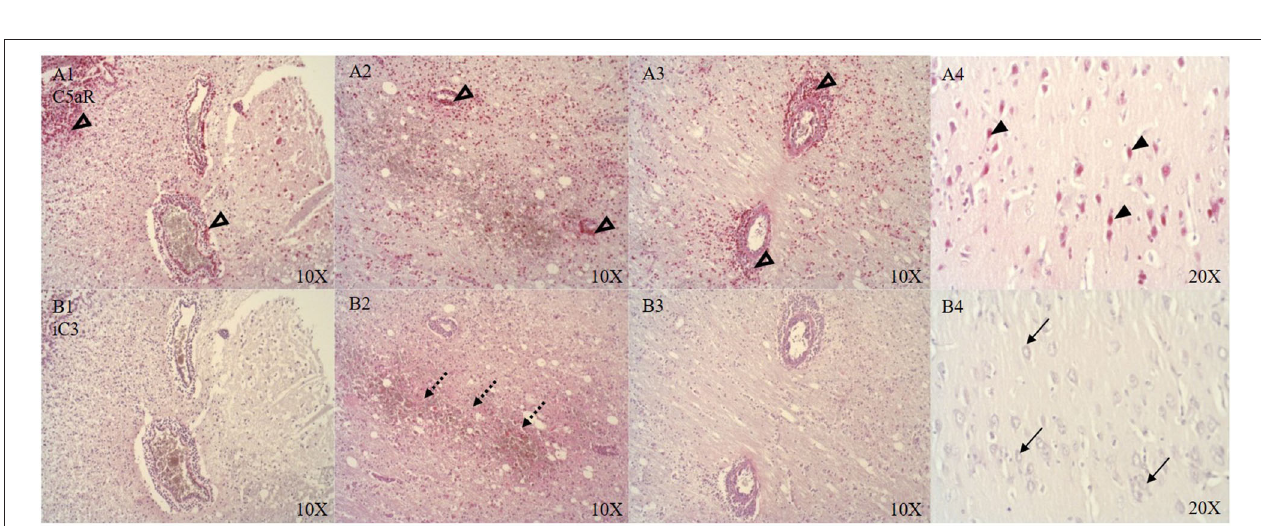
Frontiers in Neurology | www.frontiersin.org